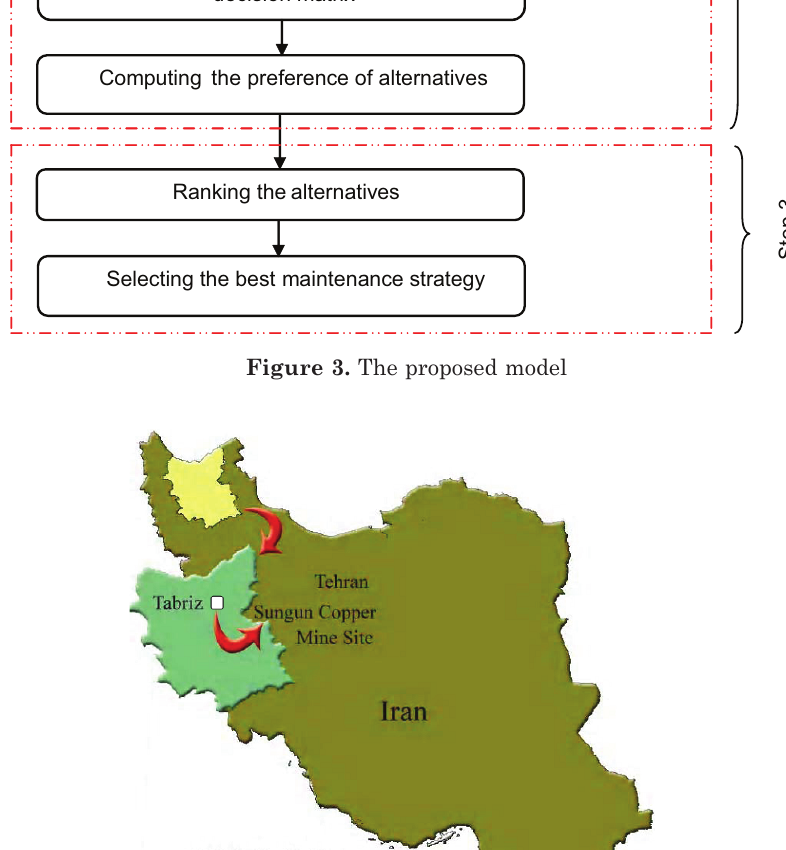
figure 4. location map of sungun copper mine in Iran (Bidhendi et al.,